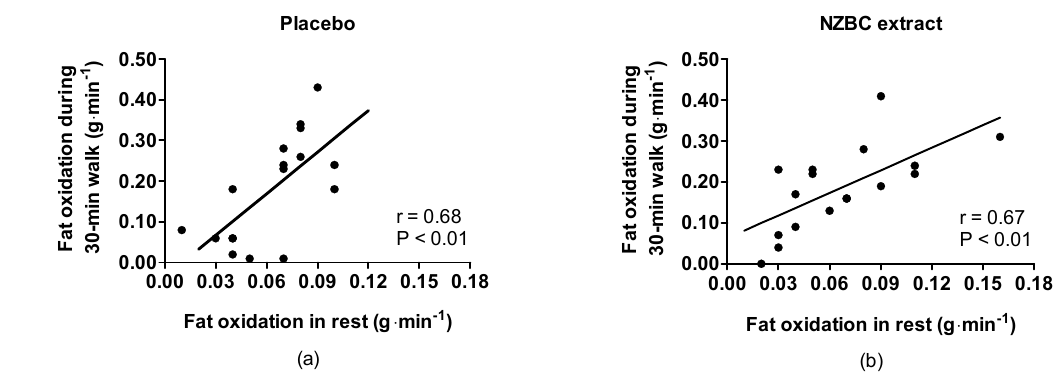
Figure 1. Relationship between whole-body fat oxidation at rest and during a five metabolic equivalent walk for 30 min ( a ) with a placebo and ( b ) under New Zealand blackcurrant (NZBC) extract conditions. The Pearson correlation coefficient was significant in both conditions.